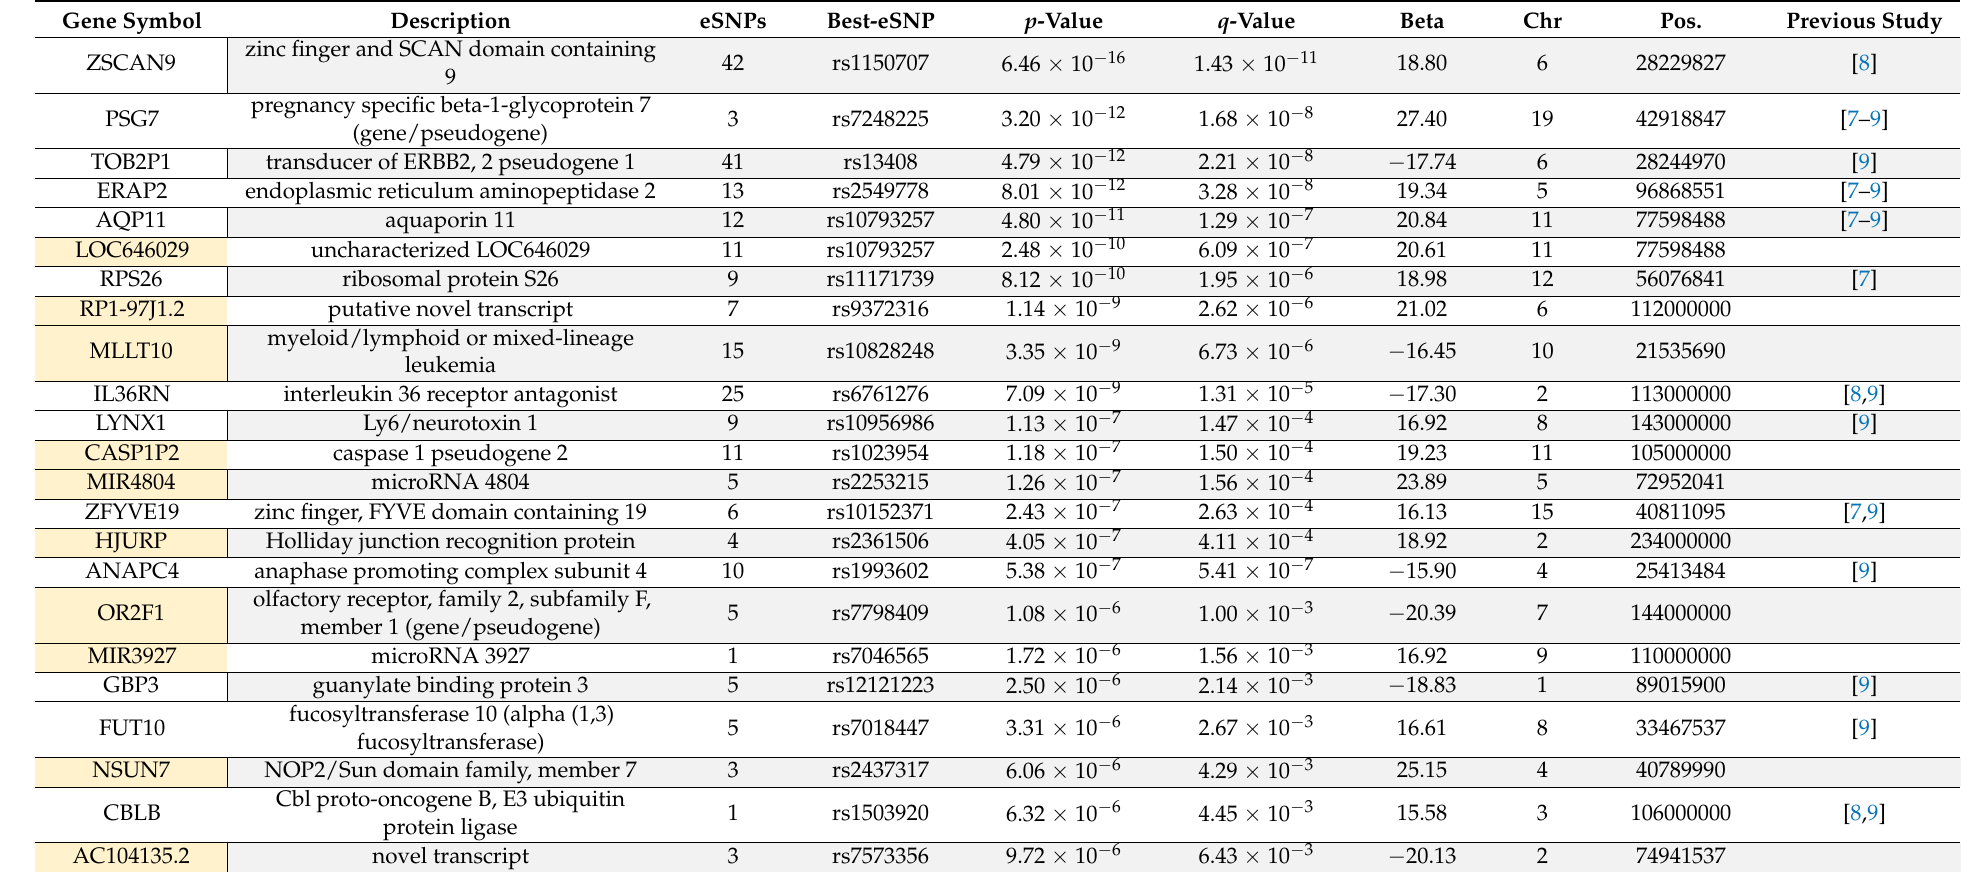
Table 2. List of eGenes, with the most significant cis-eQTL for the ALL COVARIATES dataset. The table lists the total number of eGenes correlating with the identified significant cis-eQTLs; for each eGene the total number of eSNPs are listed, and the details of the Best-eSNP reported. The Best-eSNP, in this case, is defined as the most significant cis-eQTL associated with each eGene (smallest recorded q -value). Beta corresponds to the slope coefficient for the multivariate linear model and is an estimation of the eSNP effect size on gene expression variance. Novel placental eGenes are highlighted in yellow. If the eGene had been previously identified as such, the studies are specified in the “Previous study”